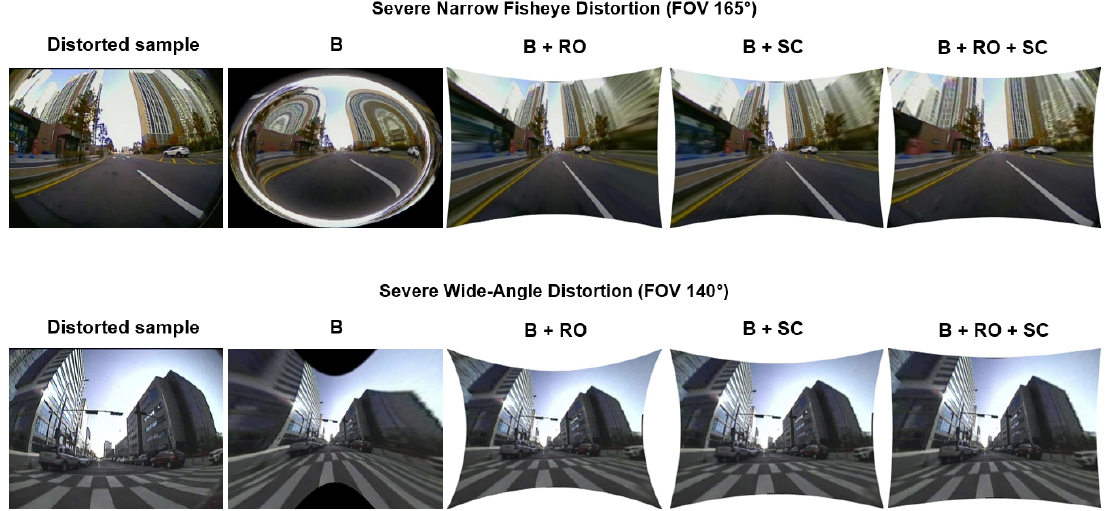
Figure 6. Qualitative: Significance of proposed cumulative set aggregation loss and refinement scheme with respect to severe